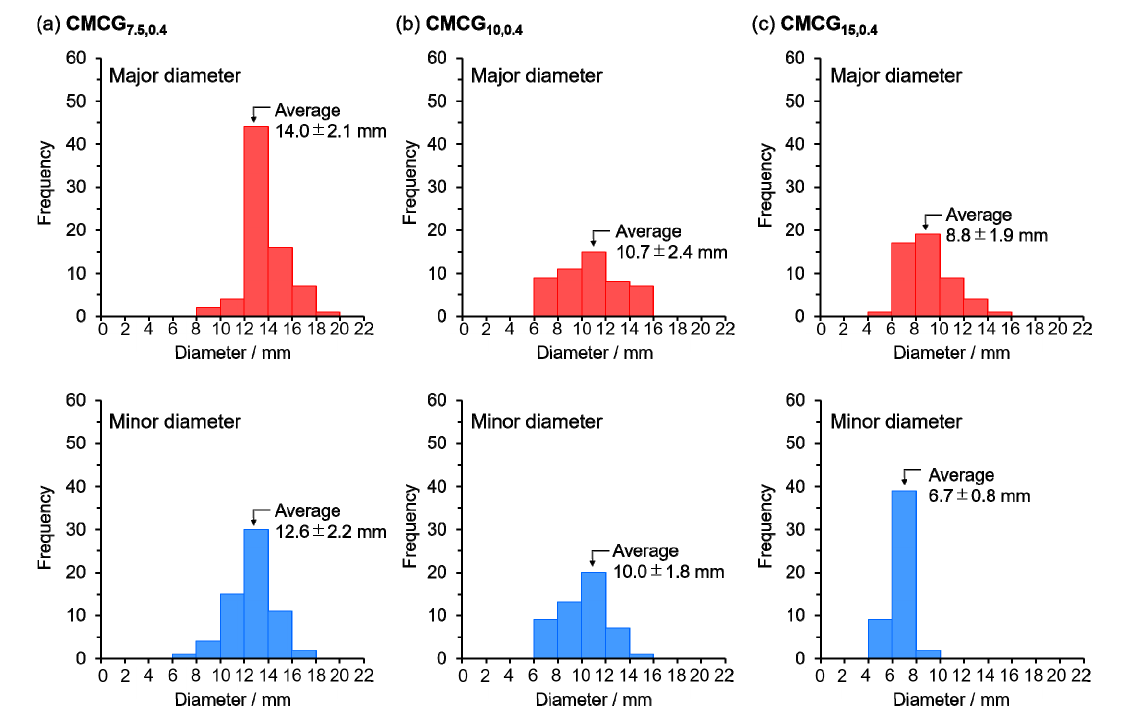
Figure 4. Size distributions of the major and minor diameters of ( a ) CMCG 7.5,0.4 , ( b ) CMCG 10,0.4 , and ( c ) CMCG 15,0.4 swollen in PBS.